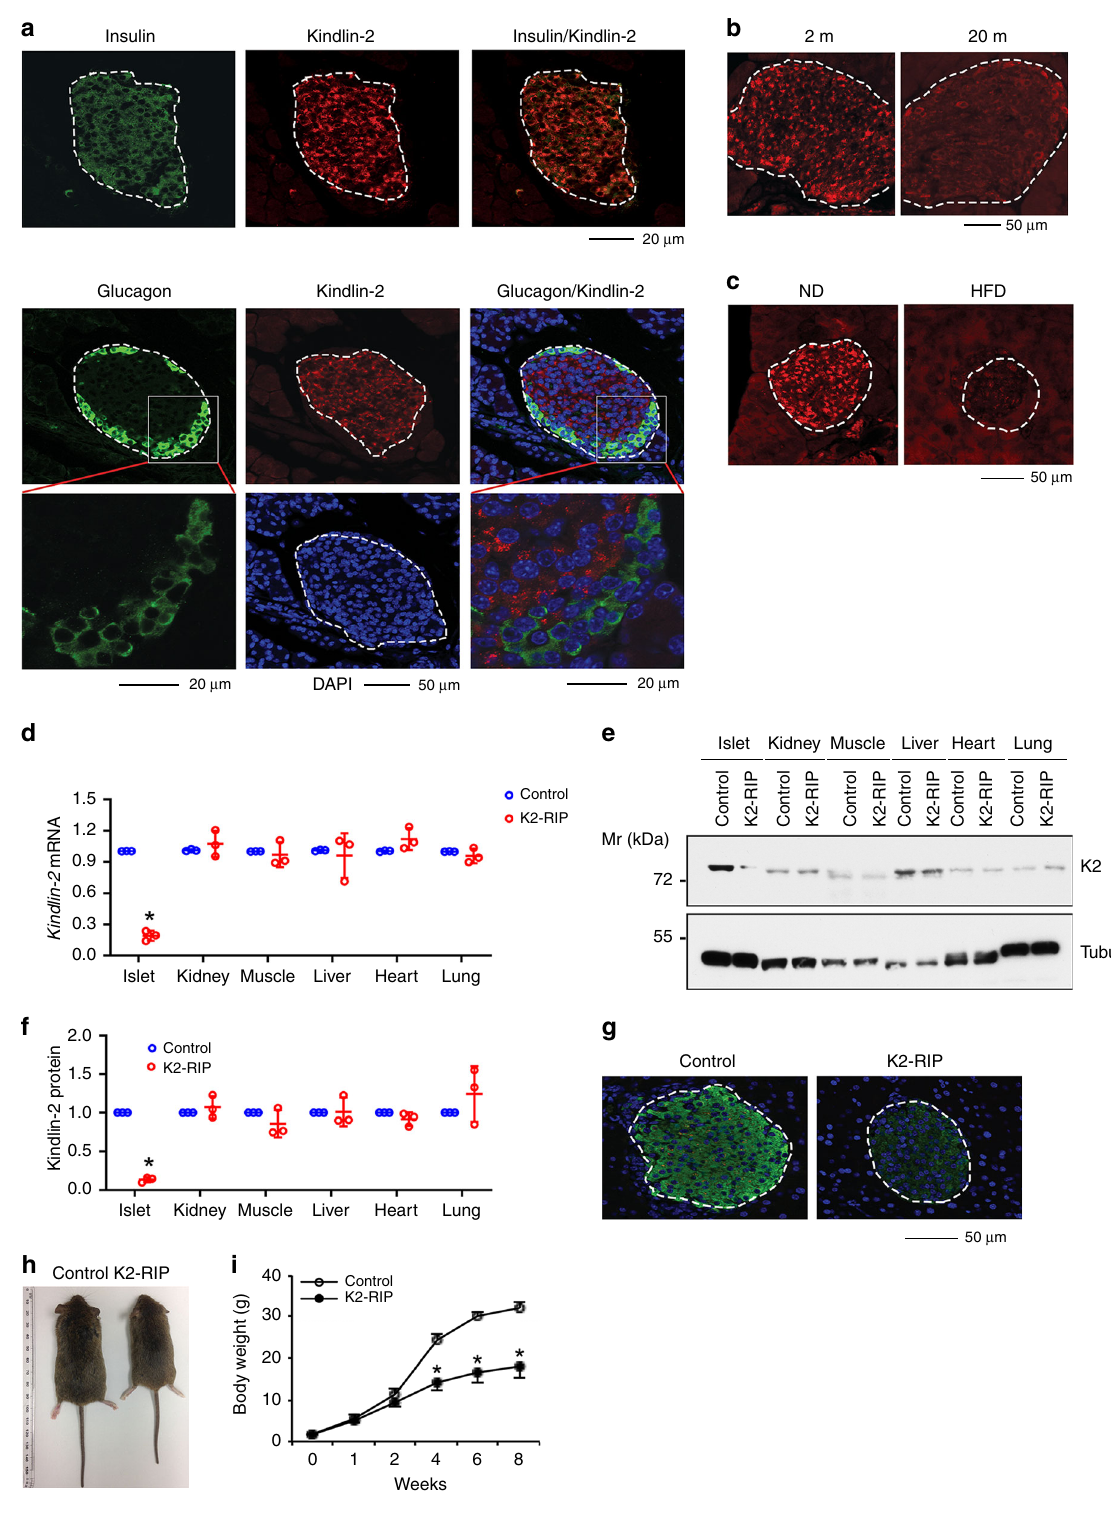
We next measured the level of fasting blood glucose and observed a signi fi cant elevation in 2- and 4-month-old male K2- RIP mice compared with age- and sex-matched control littermates ( P < 0.05, Student ’ s t test) (Fig. 2a and Supplementary Fig. 1a). We further performed the glucose tolerance test (GTT). Mice were given a single intraperitoneal (i.p.) injection of glucose (2 g/kg body weight) and blood samples were then taken to determine how quickly glucose was cleared from the blood.